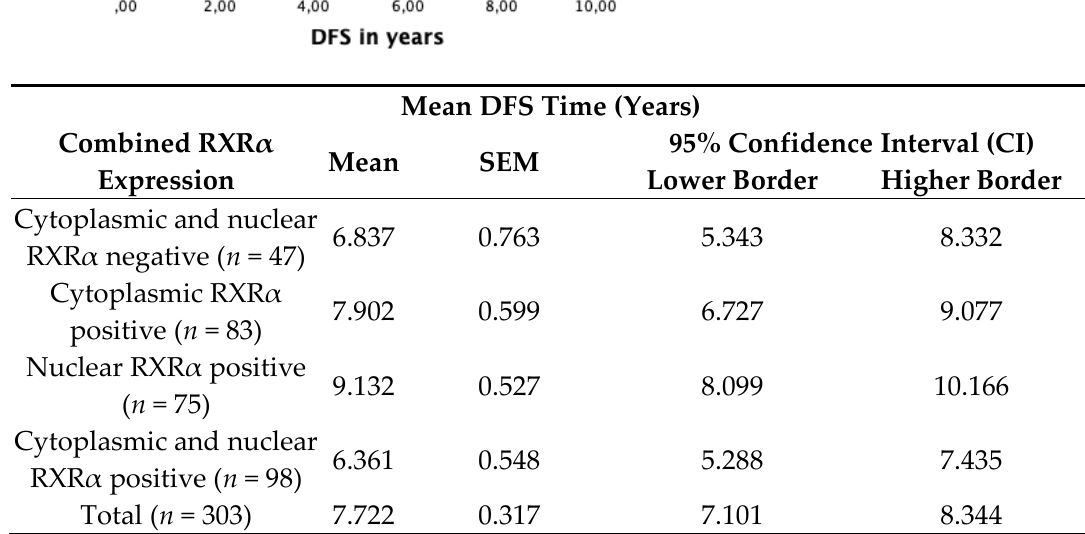
Figure 7. Kaplan –Meier survival analysis of the four combinatorial phenotypic RXRα groups and their expression in relation to DFS. Statistical significance is shown as p -values determined using the log-rank-test ( p < 0.05). The risk table demonstrates the mean survival time, SEM and 95% confidence interval (CI) for univariate analyses.